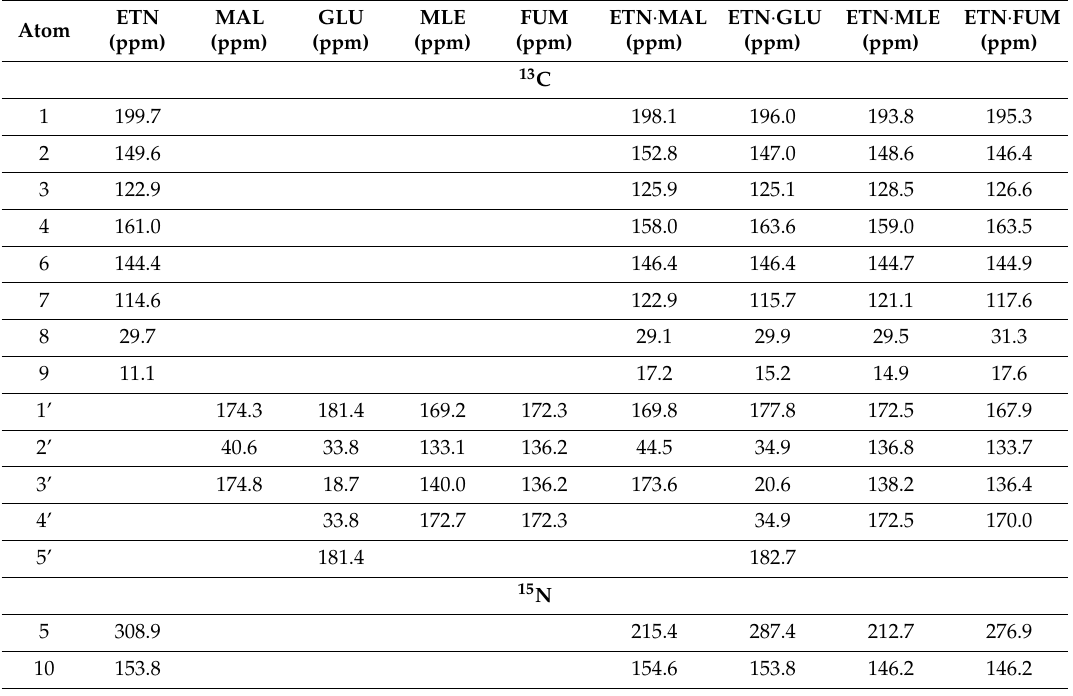
Table 3. 13 C and 15 N SSNMR chemical shift values for all analyzed powders. The atom numbering is referred to as Scheme 1.